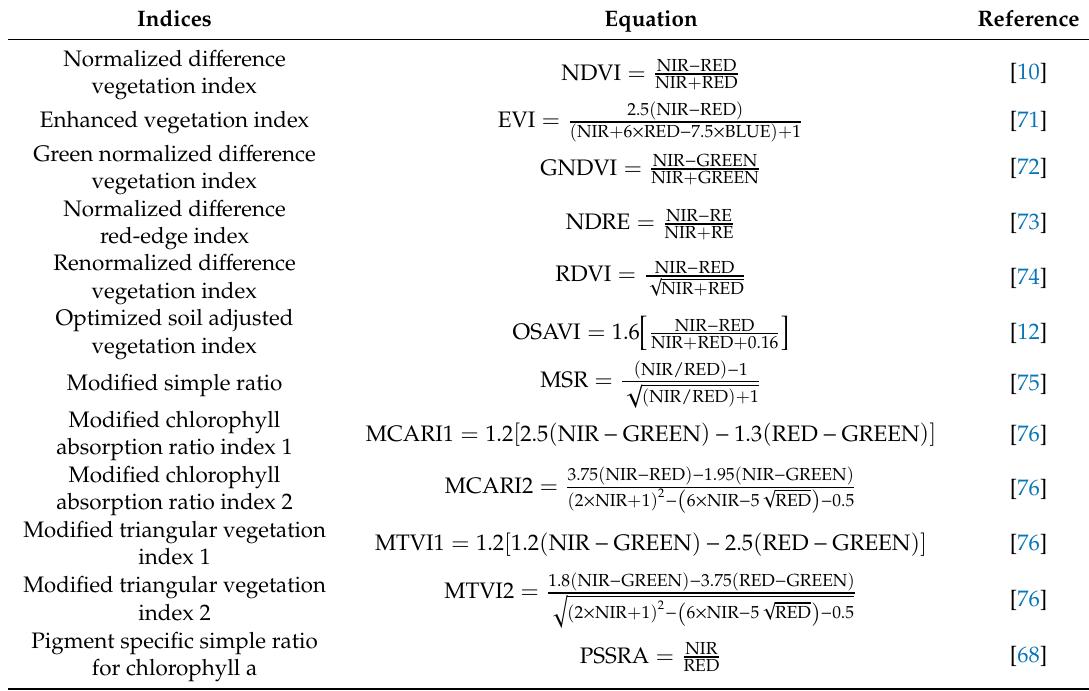
Table 1. List of commonly used vegetation indices relating to physiology and canopy